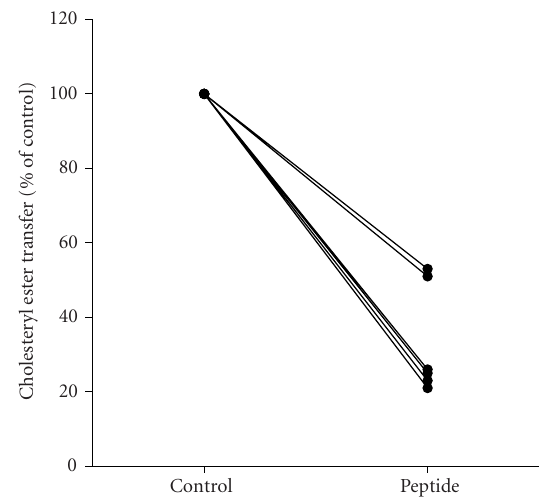
Figure 1. E ff ect of truncated apoC-I peptide on the mass trans- fer of cholesteryl ester from HDL to VLDL + LDL in reconsti- tute assays ( n = 6). The cholesteryl ester transfer in the plasma was measured by adding the truncated apoC-I peptide at a con- centration of 25 µ M, as described in “methods.” The decrease in cholesteryl ester transfer in plasma added with the truncated peptide (peptide) has been expressed as the percent of transfer in the plasma without the truncated peptide